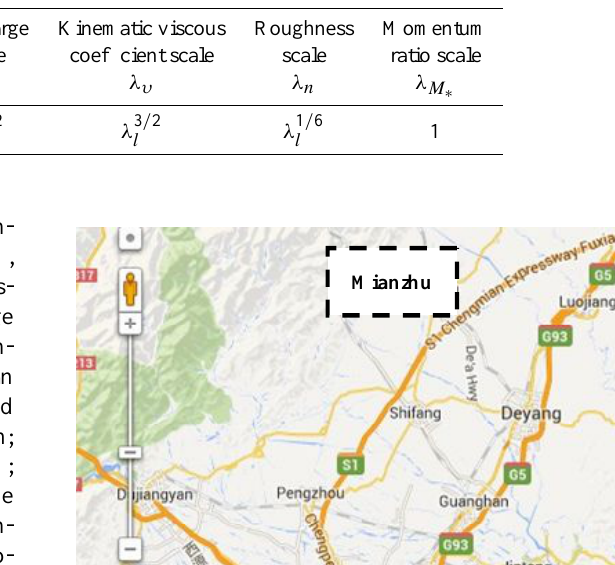
Figure 1. The geographic location of the study area (from Google)